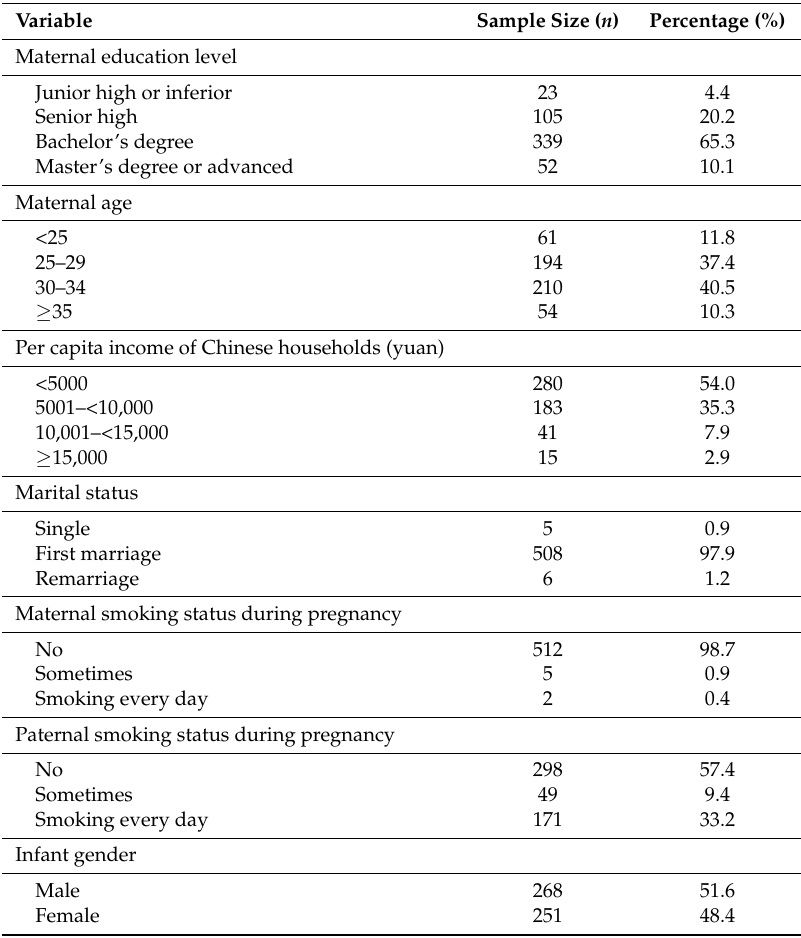
Table 1. Baseline characteristics of infants and their mothers in Changsha, China, 2013–2014.